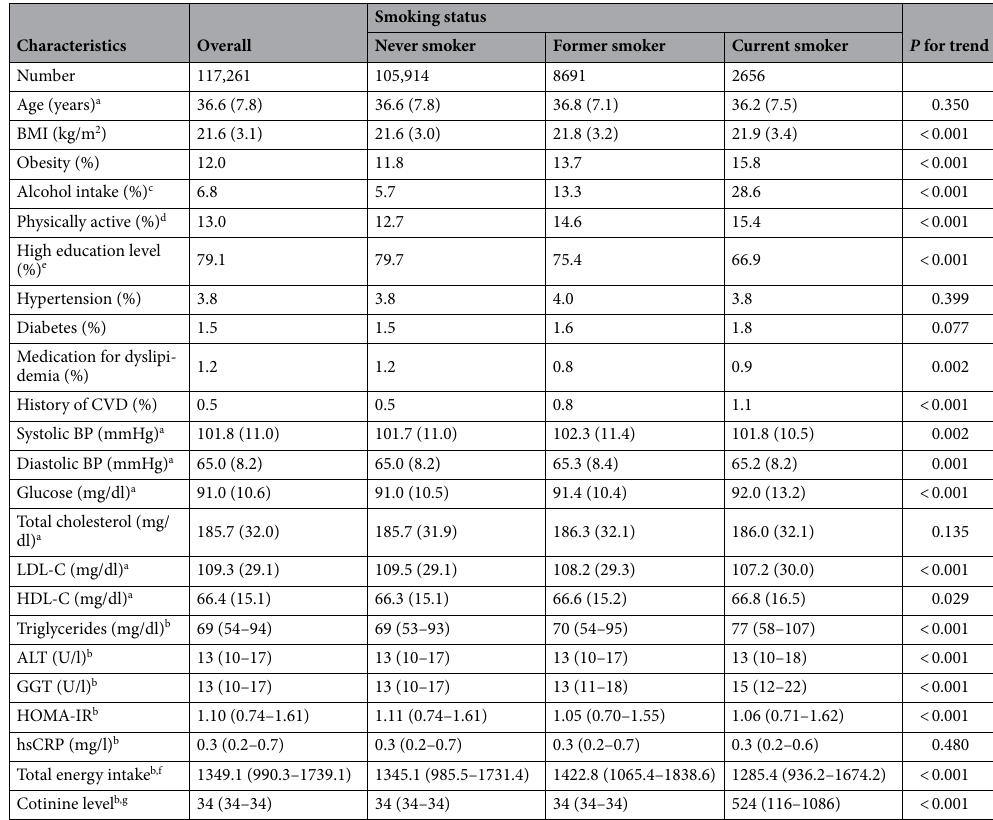
Table 2. Baseline characteristics of study participants according to smoking status among women. Data are presented as a means (standard deviation), b medians (interquartile range), or percentages. BMI body mass index, BP blood pressure, LDL-C low-density lipoprotein-cholesterol, HEPA health-enhancing physically active, HDL-C high-density lipoprotein-cholesterol, HOMA-IR homeostasis model assessment of insulin resistance, hsCRP high sensitivity C-reactive protein. c ≥ 20 g of ethanol per day; d ≥ health enhancing